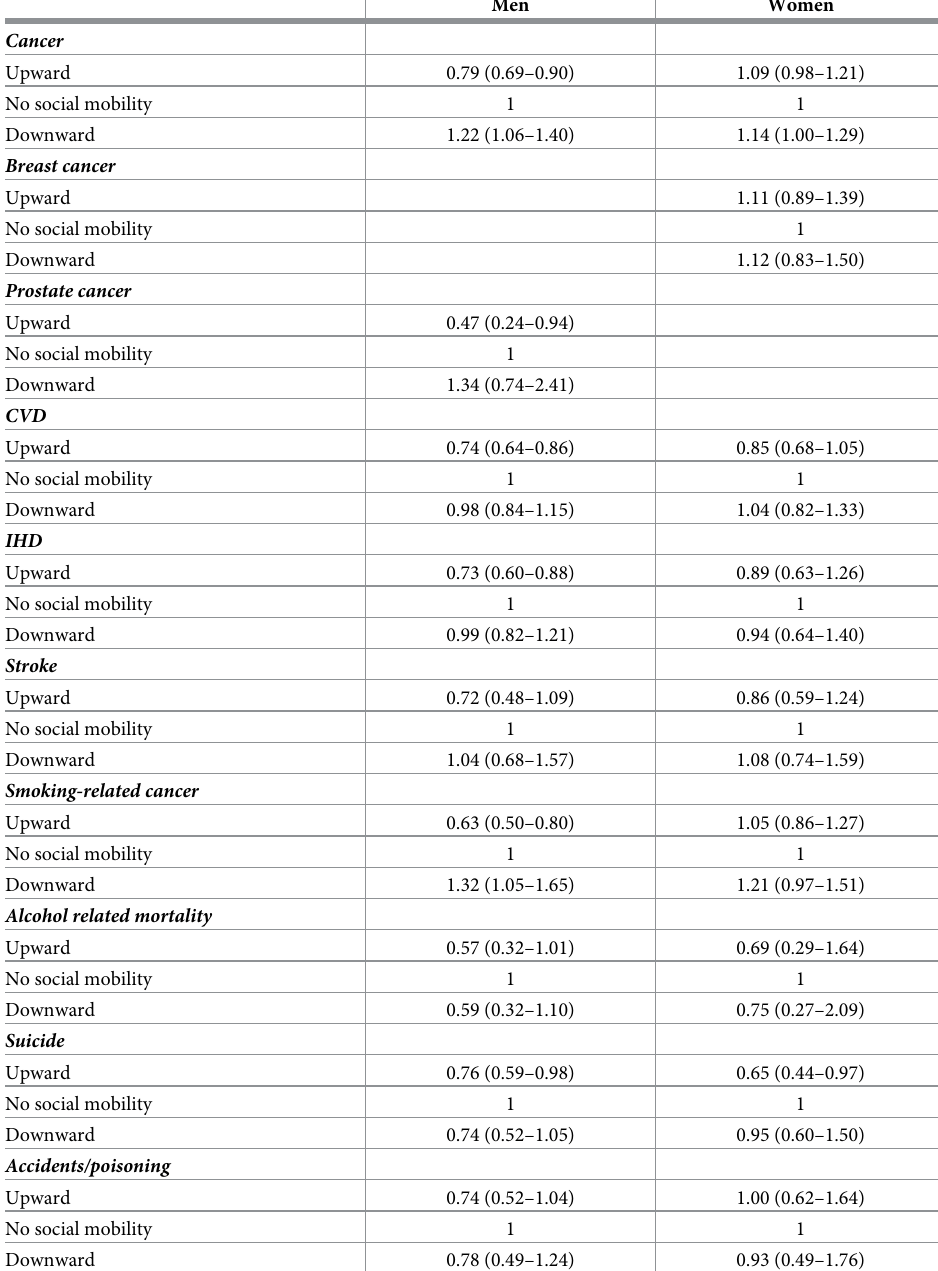
Table 5. Selected model results for cause-specific mortality from 1997 to 2012: Odds ratios (and 95% confidence intervals) from discrete time hazard analysis